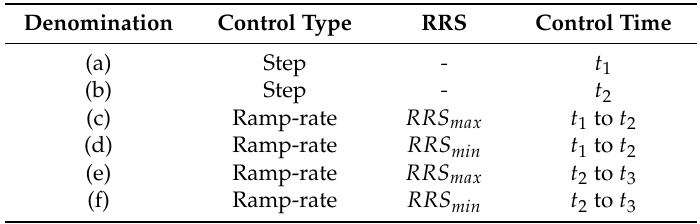
Table 1. Six different active power control strategies.